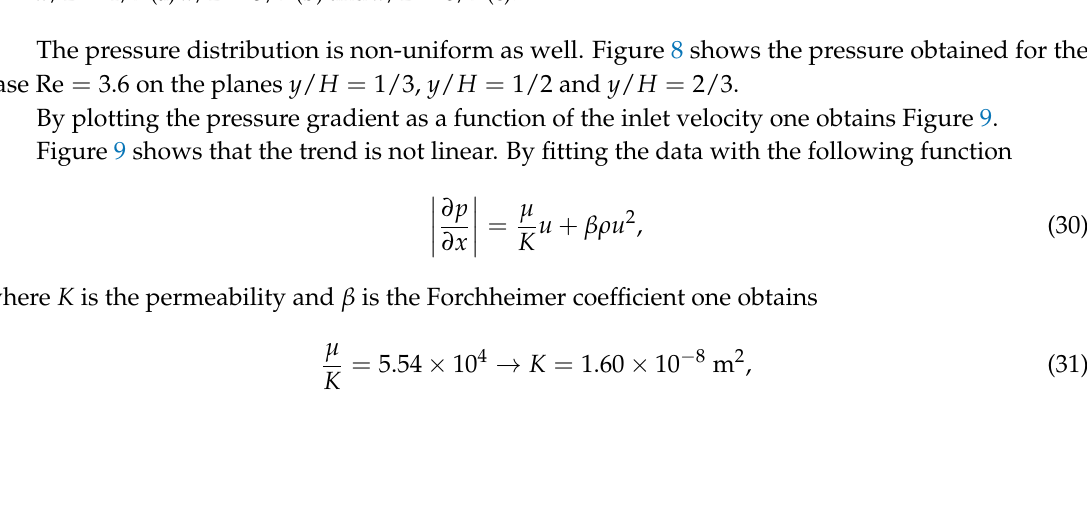
Figure 7. Velocity distribution on different sections of the metal foam for the case Re = 21.6. Sections x / L = 4/7 ( a ) x / L = 5/7 ( b ) and x / L = 6/7 ( c